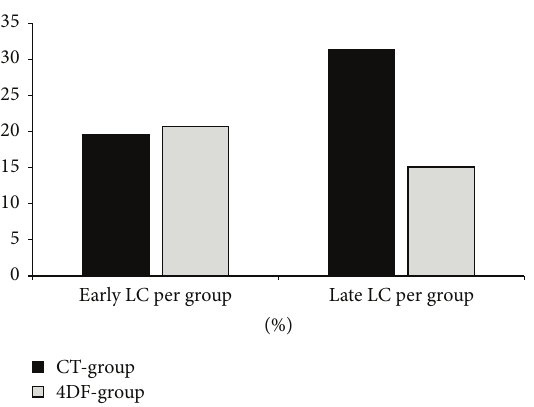
Figure 3: Early and late lymphocele findings as a percentage of the respective patient cohort size (CT-group: 51 patients, 4DF-group: 53 patients).